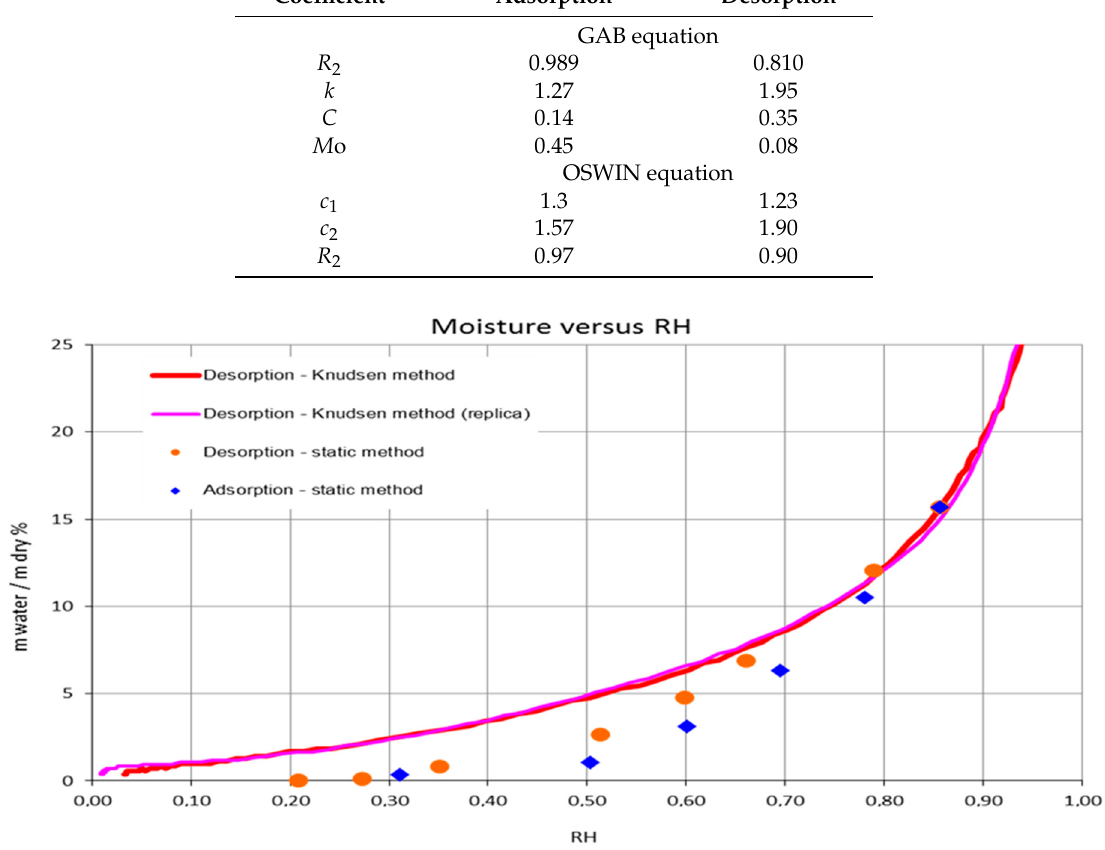
Figure 7. CNCs adsorption and desorption isotherm at 25 °C according to the standard static gravimetric method, and desorption isotherms according the Knudsen thermogravimetry method.